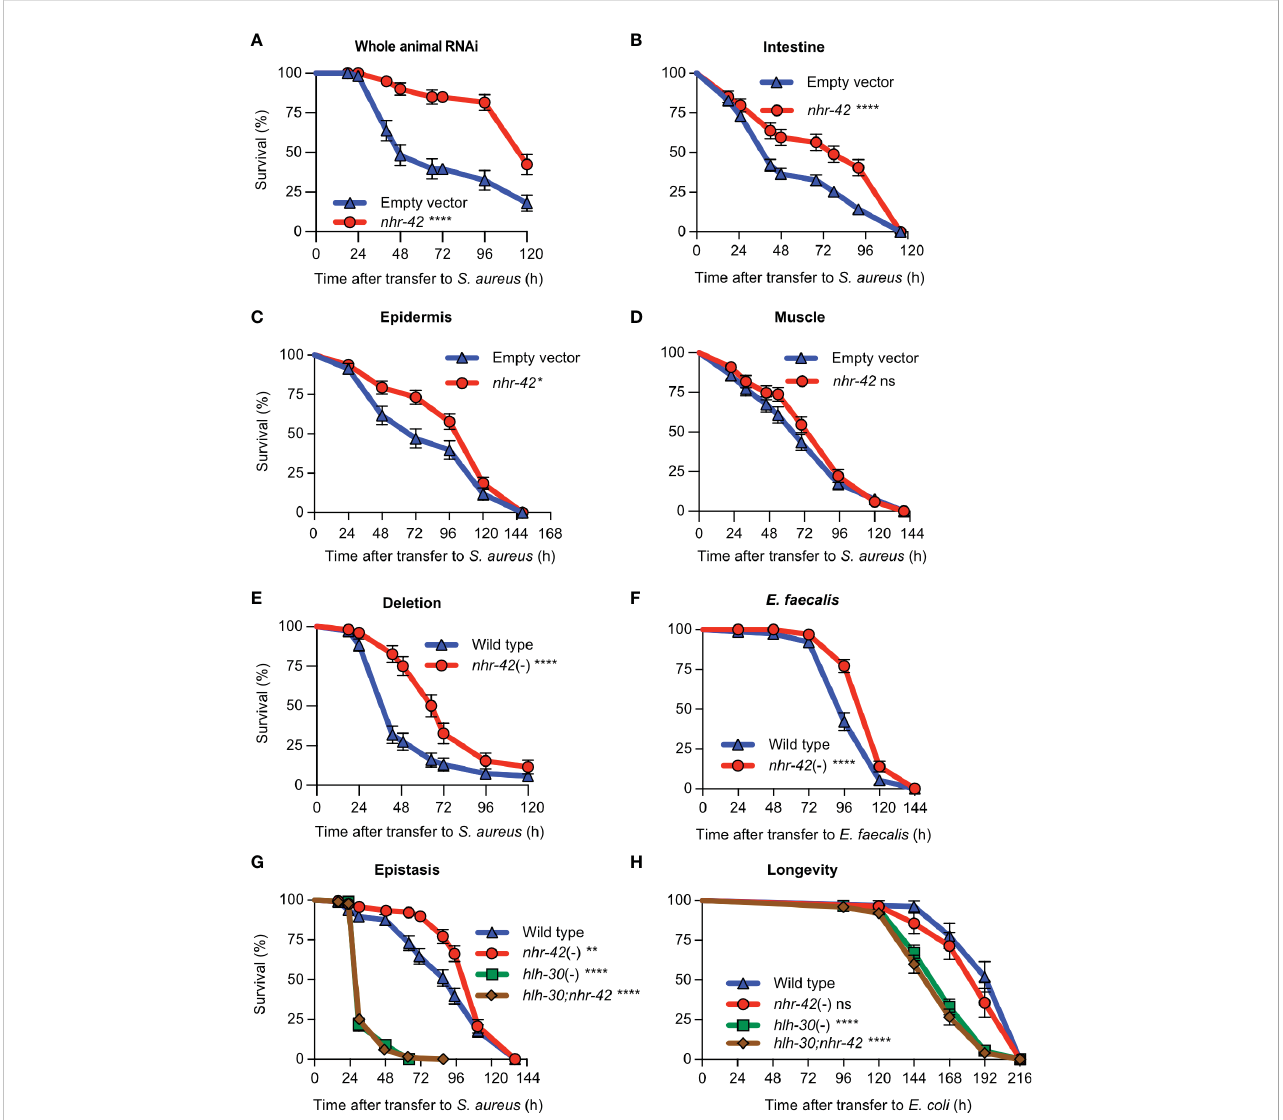
FIGURE 2 nhr-42 represses infection survival (A) Survival of wild type animals fed E. coli HT115 expressing RNAi empty vector or nhr-42 dsRNA during S. aureus SH1000 infection. Data are representative of two independent replicates. (B) Survival of intestine-speci fi c MGH171 RNAi animals fed E. coli expressing RNAi empty vector or nhr-42 dsRNA during S. aureus SH1000 infection. Data are representative of two independent replicates. (C) Survival of hypodermis-speci fi c RNAi NR222 animals fed E. coli expressing RNAi empty vector or nhr-42 dsRNA during S. aureus SH1000 infection. Data are representative of two independent replicates. (D) Survival of muscle-speci fi c RNAi NR350 animals fed E. coli expressing RNAi empty vector or nhr-42 dsRNA during S. aureus SH1000 infection. Data are representative of two independent replicates. (E) Survival of wild type and nhr-42 (tm1375) animals during S. aureus SH1000 infection. Data are representative of 3 independent replicates. (F) Survival of wild type and nhr-42 (tm1375) animals during E. faecalis infection. Data are representative of 3 independent replicates. (G) Survival of wild type, nhr-42 (tm1375), hlh-30 (tm1978), and hlh-30;nhr-42 double mutants during S. aureus infection. Data are representative of 3 independent replicates. (H) Lifespan of wild type, nhr-42 (tm1375), hlh-30 (tm1978), and hlh-30;nhr-42 double mutants fed E. coli OP50 (25°C). Data are representative of 3 independent replicates.* P ≤ 0.05, ** P ≤ 0.01, *** P ≤ 0.001, **** P ≤ 0.0001. ns, not signi fi cant. Log-Rank (Kruskal-Wallis) test. N = 90-135 animals per